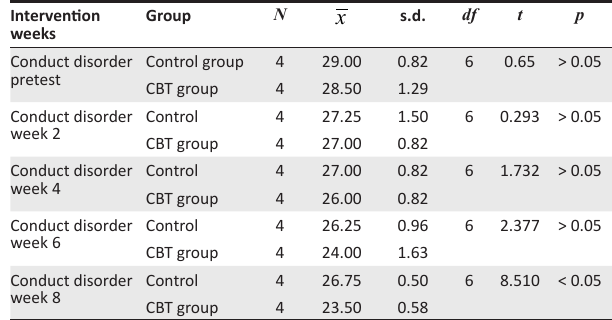
TABLE 1: Summary of t -test showing the significant difference in conduct disorder between the experimental group (cognitive-behavioural therapy) and the control group.